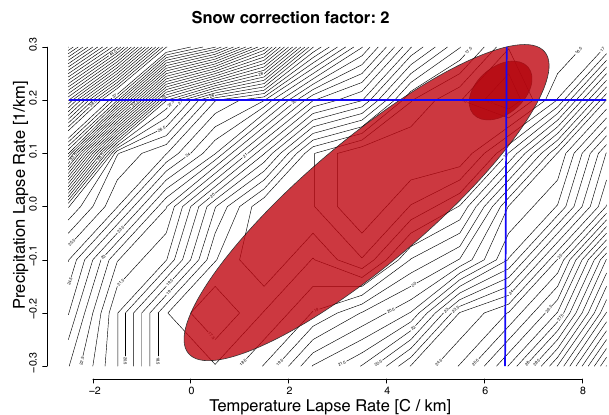
Fig. 4. Contour plot of the RMSD for simulated compared to ob- served MD around Piz Corvatsch, Switzerland (Gubler et al., 2011; Schmid et al., 2012). The smallest RMSDs are obtained for a a tem- perature lapse rate 6.5 ◦ Ckm − 1 , a snow correction factor of 2 and a precipitation lapse rate of 0.2km − 1 (indicated by the blue